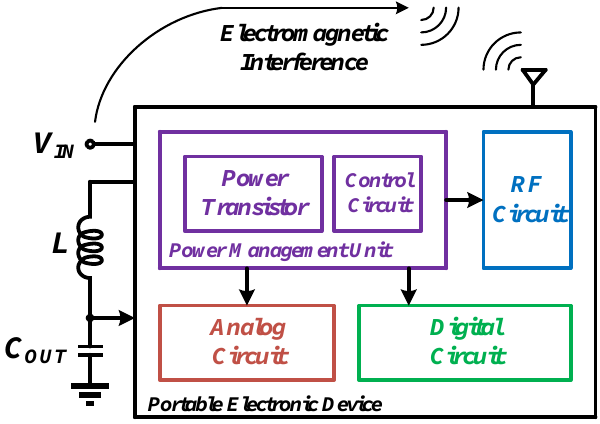
Figure 2. Electromagnetic interference of the portable electronic device.